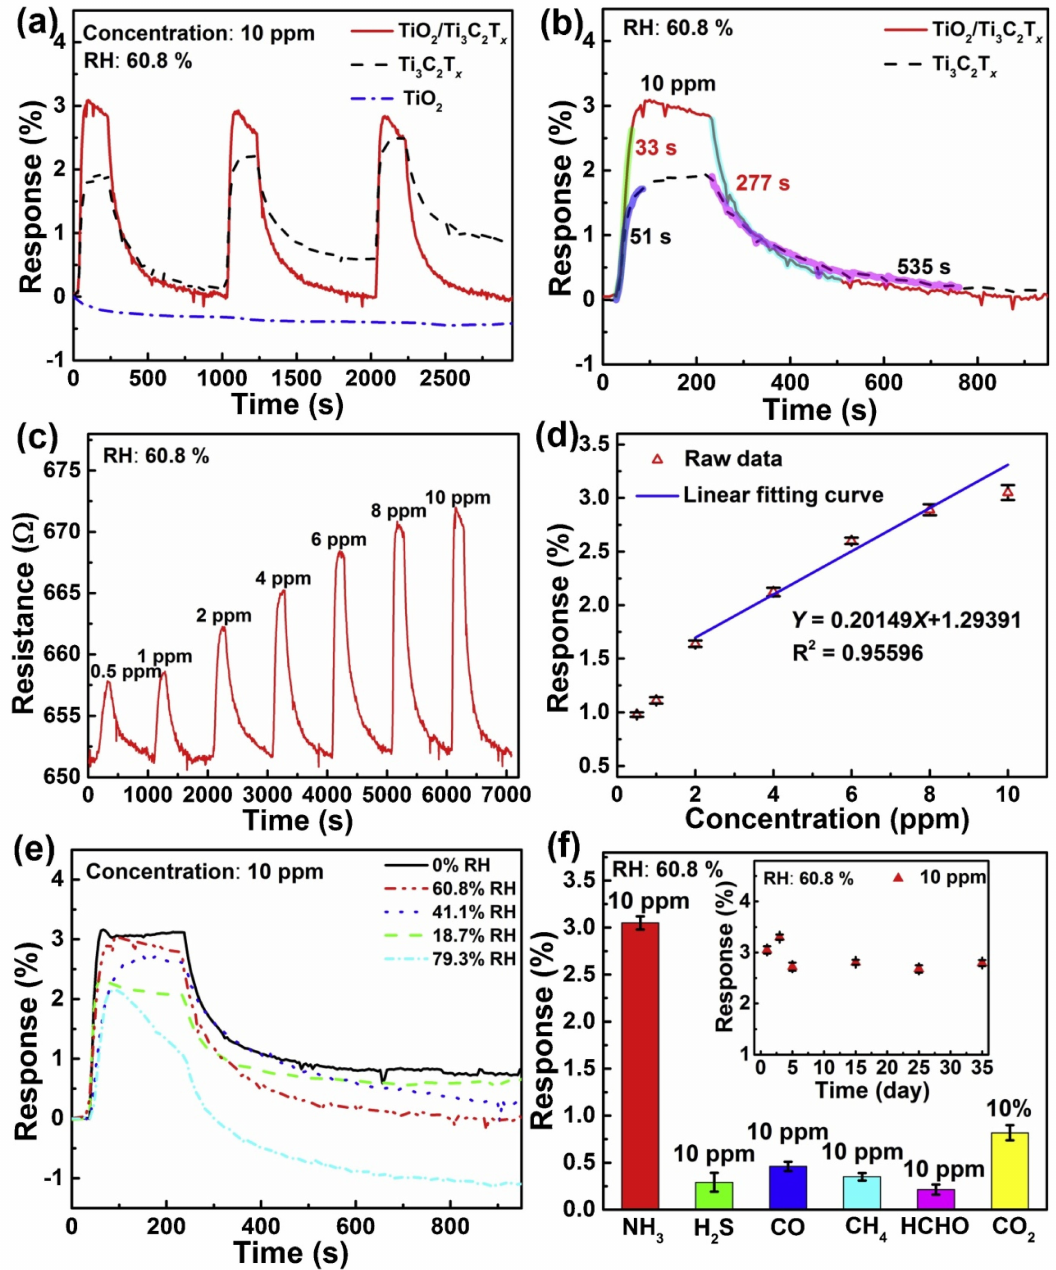
Figure 10. Performance of MXene − based sensors. ( a ) Comparison of the normalized response– recovery performance between the TiO 2 /Ti 3 C 2 T x , Ti 3 C 2 T x , and TiO 2 gas sensors at a condition of 10 ppm NH 3 ; ( b ) comparison of the response–recovery times between the Ti 3 C 2 T x and TiO 2 /Ti 3 C 2 T x sensors; ( c ) dynamic response − recovery curve of the TiO 2 /Ti 3 C 2 T x gas sensor to different concen- trations of NH 3 ; ( d ) relationship between the response versus NH 3 concentrations; ( e ) influence of RH on the response–recovery curves of the TiO 2 /Ti 3 C 2 T x gas sensor under 10 ppm NH 3 ; and ( f ) influence of gas types on the responses of TiO 2 /Ti 3 C 2 T x gas sensor, inset gives the long-period stability of the sensor to 10 ppm NH 3 . Operating temperature: 25 ◦ C. Reprinted with permission from Ref. [112]. 2019,